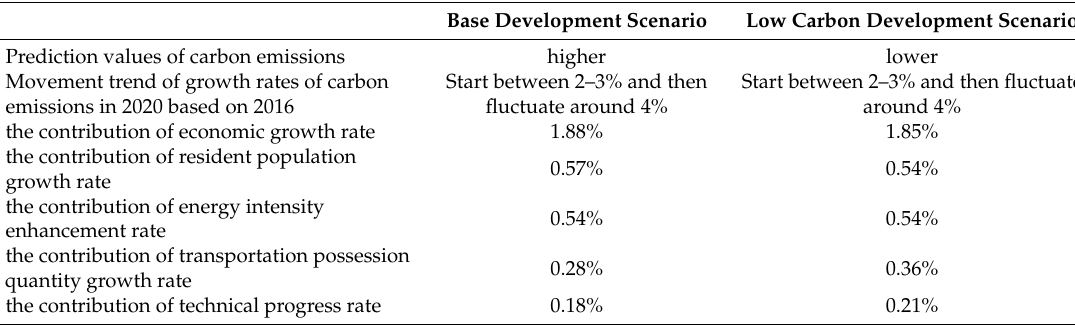
Table 10. Comparison results for two main development